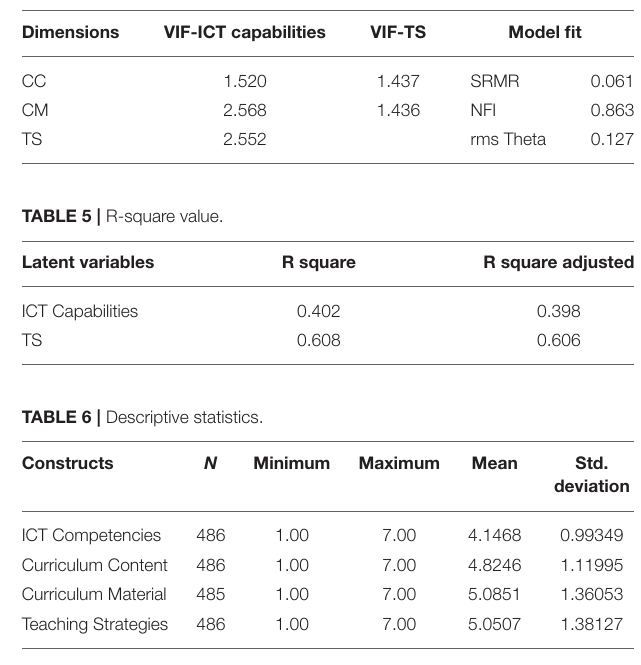
TABLE 4 | Collinearity analysis and model fit.